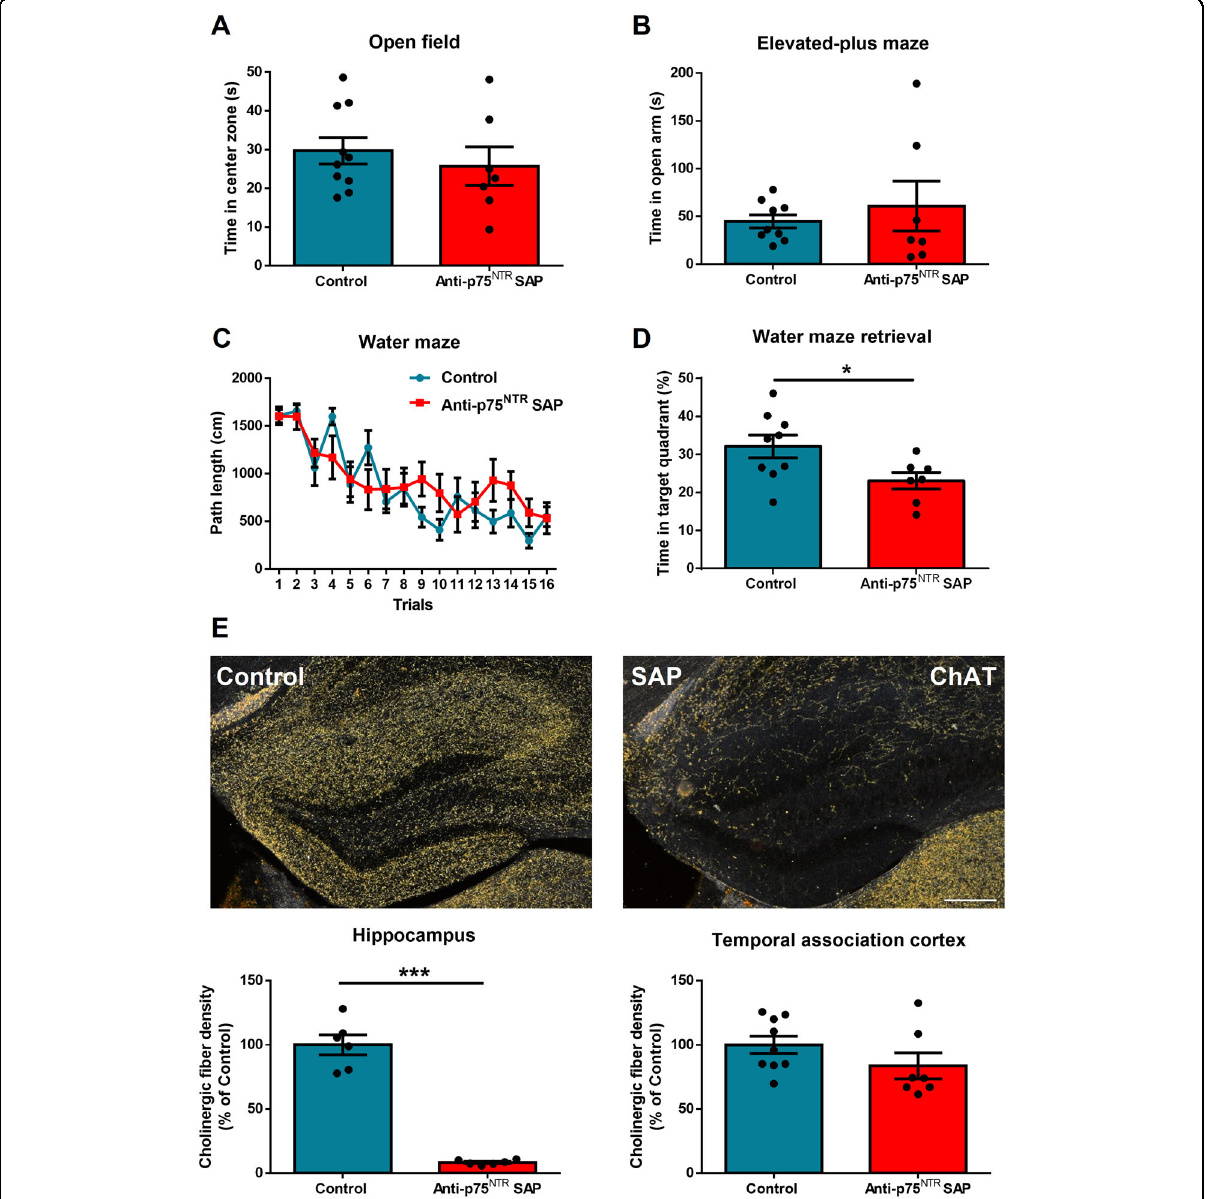
Fig. 4 Hippocampal cholinergic depletion causes impaired spatial memory but no effect on anxiety. A , B C57 Mice injected in the hippocampus with anti-p75 NTR Saporin to deplete cholinergic fi bers (hippocampal cholinergic depletion) were not different to controls on the open fi eld or elevated plus maze ( n = 7 – 10). C , D Hippocampal cholinergic depletion did not effect spatial learning but impaired spatial memory. E Images of ChAT staining in PBS or anti-p75 NTR Saporin-injected hippocampus. We con fi rmed that mice with anti-p75 NTR Saporin injection had a profound decrease in cholinergic fi ber density in the hippocampus without affecting the cortex ( n = 6 –